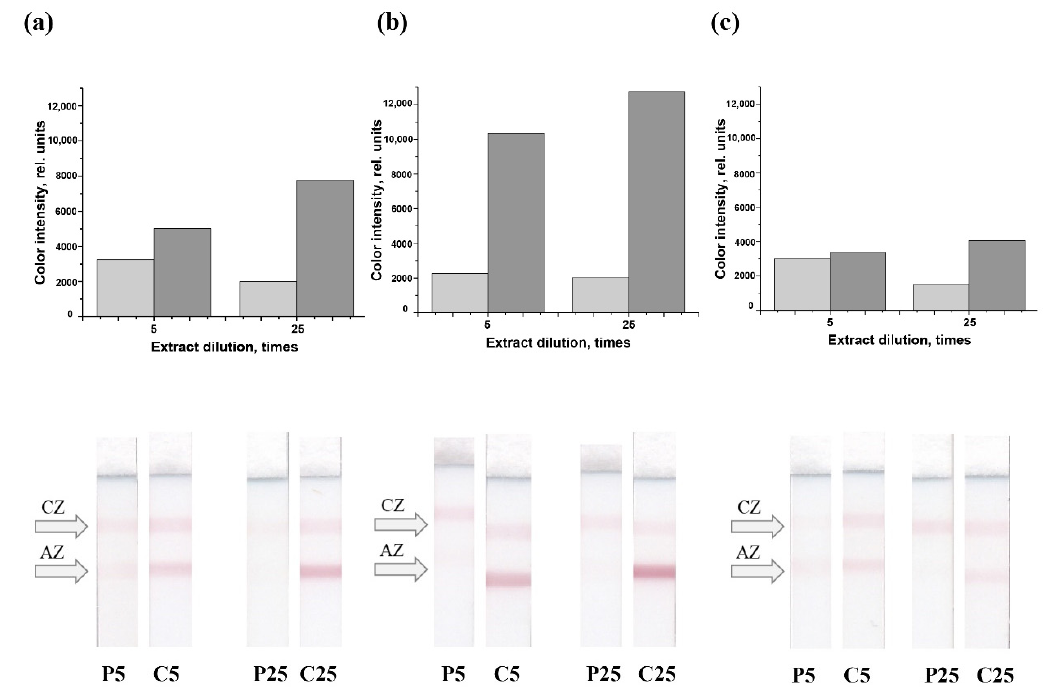
Figure 5. ICA responses ( n = 3) for 5-fold and 25-fold diluted extracts of pork (gray columns, P5 and P25 test strips) and chicken meat (dark gray columns, C5 and C25 test strips) for (C5 + RACI)-GNPs conjugates of different compositions in which the weight/weight ratio of MAb C5 and RACI in the mixed solution for immobilization was 50/50% ( a ), 20/80% ( b ), and 80/20% ( c ). AZ—analytical zone, CZ—control zone.